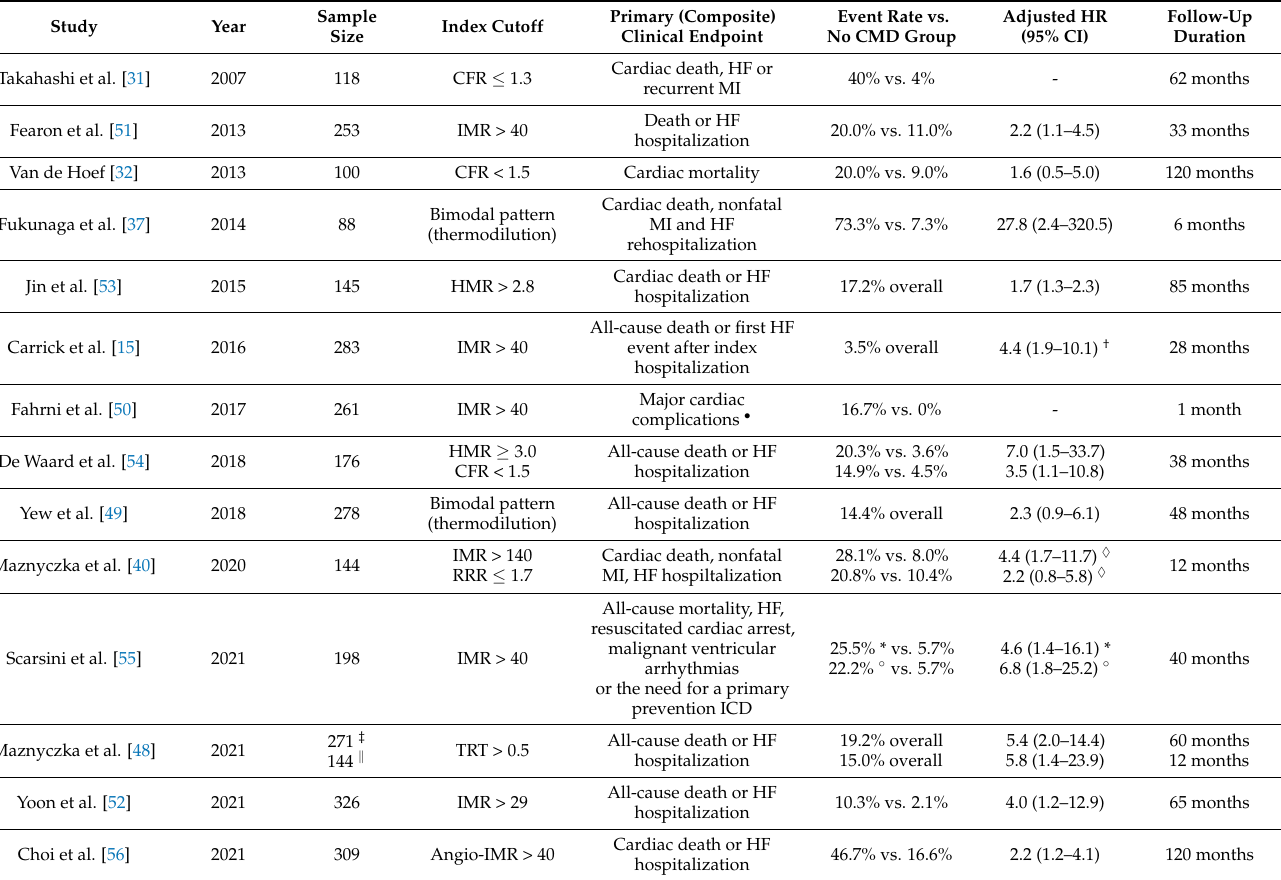
Table 1. Selected studies showing association of different invasive parameters of microvascular resistance with clinical outcomes in patients with acute myocardial infarction treated with primary PCI.